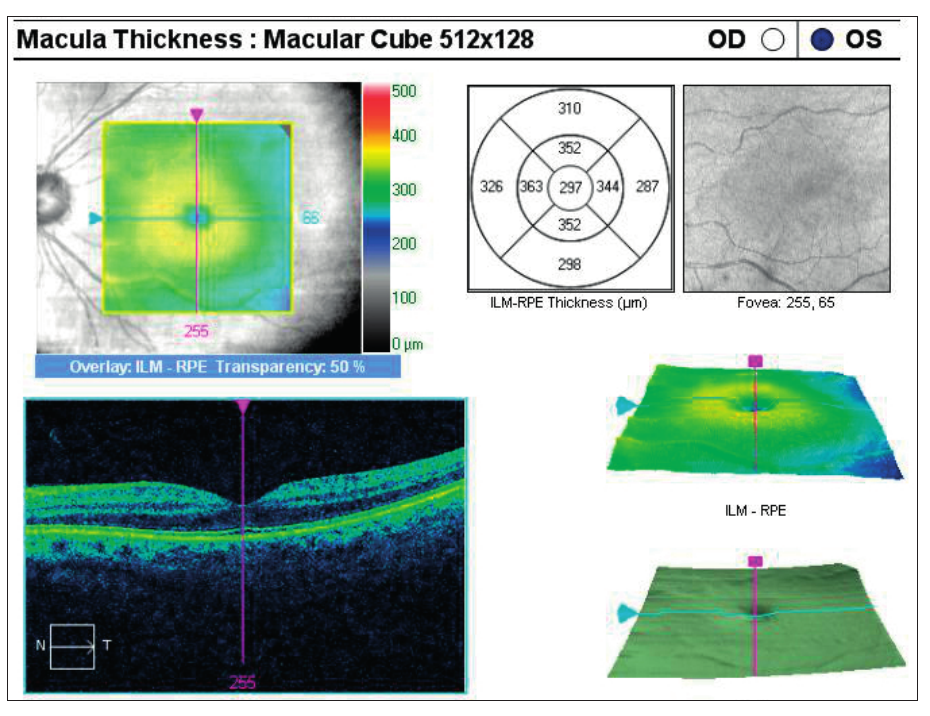
Fig. 6. Resolution of epiretinal membrane.